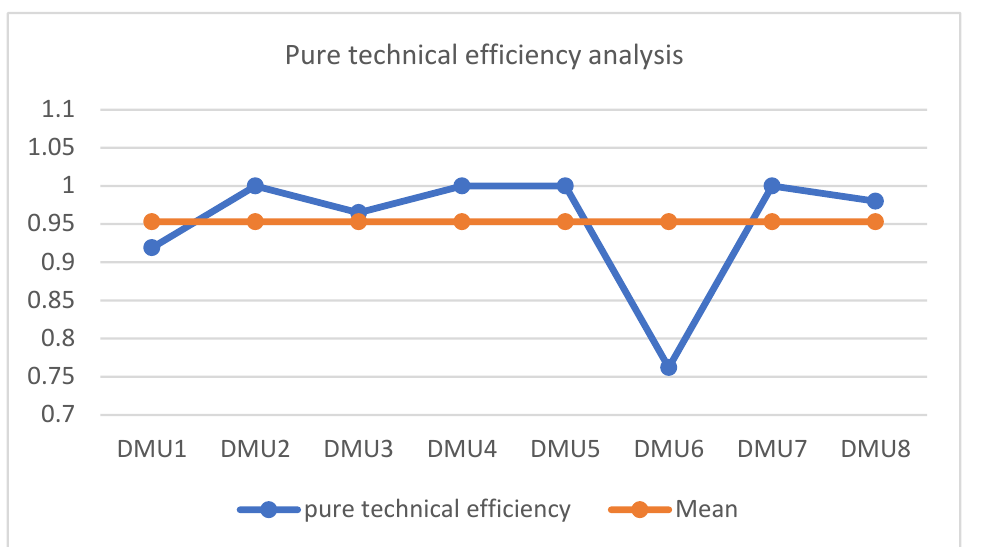
Figure 3. Comparative analysis of pure technical efficiency.